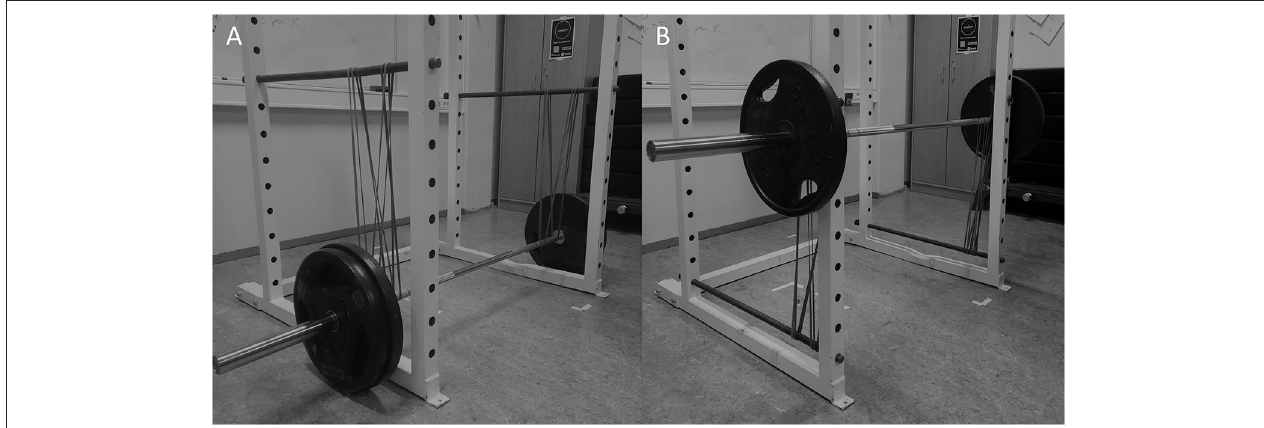
FIGURE 1 | Illustration of the set-up, showing lower position in the assisted (A) and top position in the resisted (B) deadlift. Length of the elastic bands are equal in the two positions.